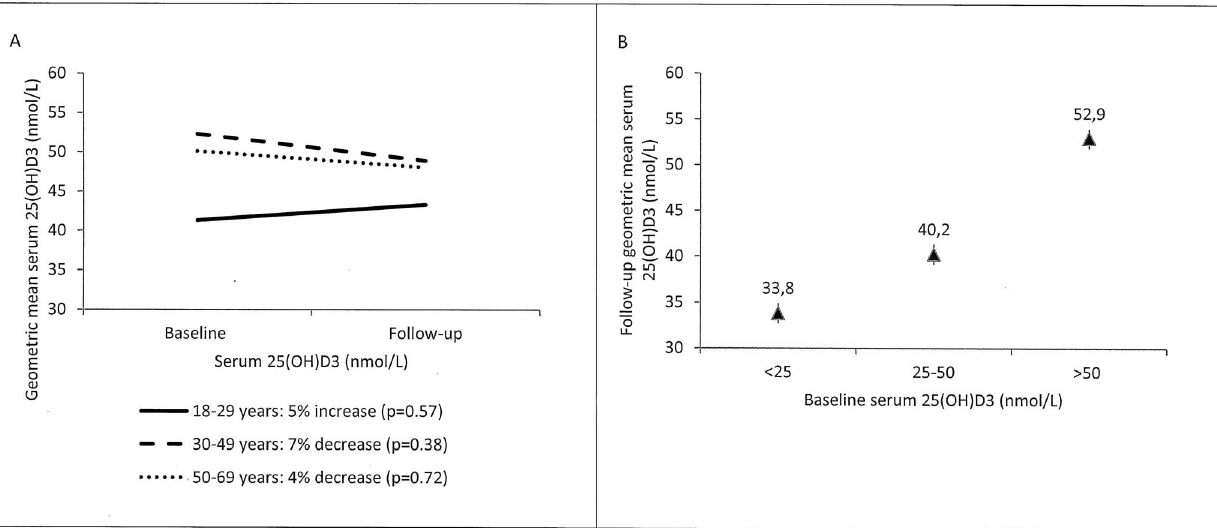
Figure 2. Baseline and follow-up concentrations of vitamin D. (A) Geometric mean serum 25(OH)D3 concentration among 138 individuals with a baseline (1987) and a follow-up (2005–2010) measurement in May-June 1987 and in May-June 2005–2010, respectively, by age group, and (B) geometric mean serum follow-up 25(OH)D3 concentration with 95% confidence interval by baseline concentration (deficiency: , 25 nmol/L; insufficiency: 25–50; sufficiency: . 50 nmol/L) after adjustment for age, gender, latitude and month of follow-up sampling among 309